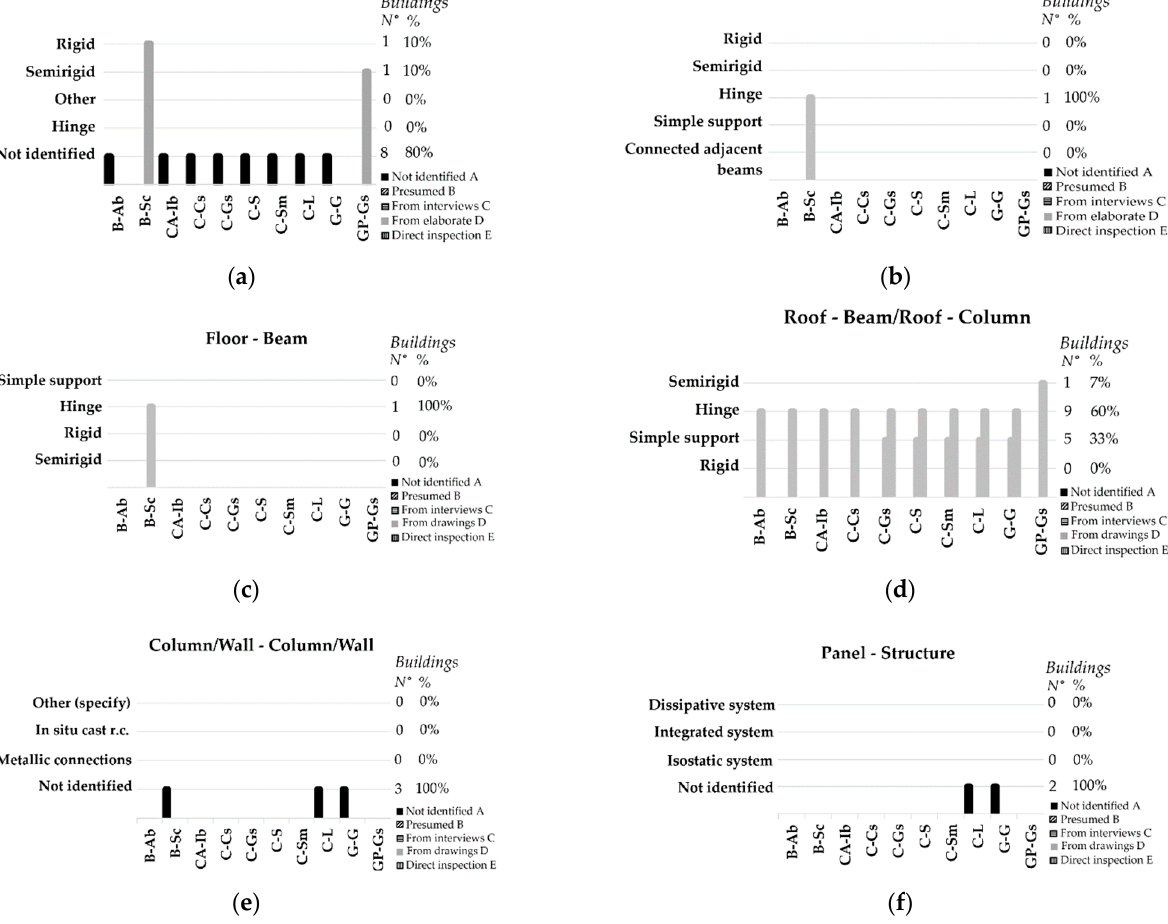
Figure 22. Section 2C CARTIS-Building. Connections: ( a ) Column/wall to foundation; ( b ) Beam to column/wall; ( c ) Floor to beam; ( d ) Roof to beam/roof to column; ( e ) Column/wall to column/wall; ( f ) Panel to structure.